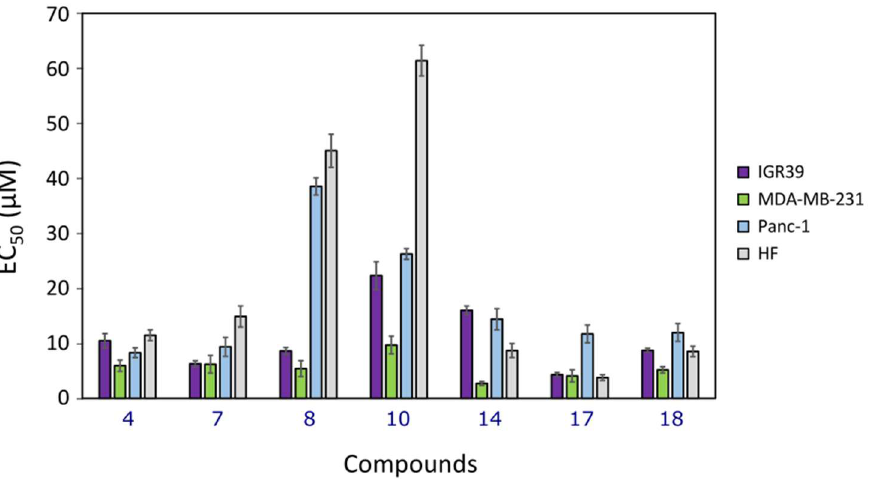
Figure 2. EC 50 values of the most active hydrazones 4, 7, 8, 10, 14, 17 and 18 , obtained by the MTT assay, n = 3.